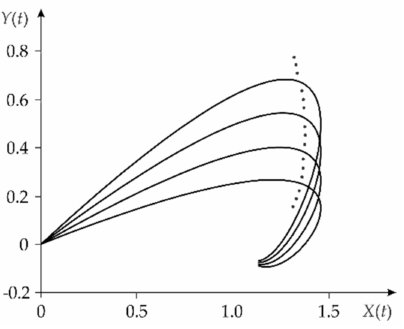
Figure 4. Group of IRNs for the SCA machine.